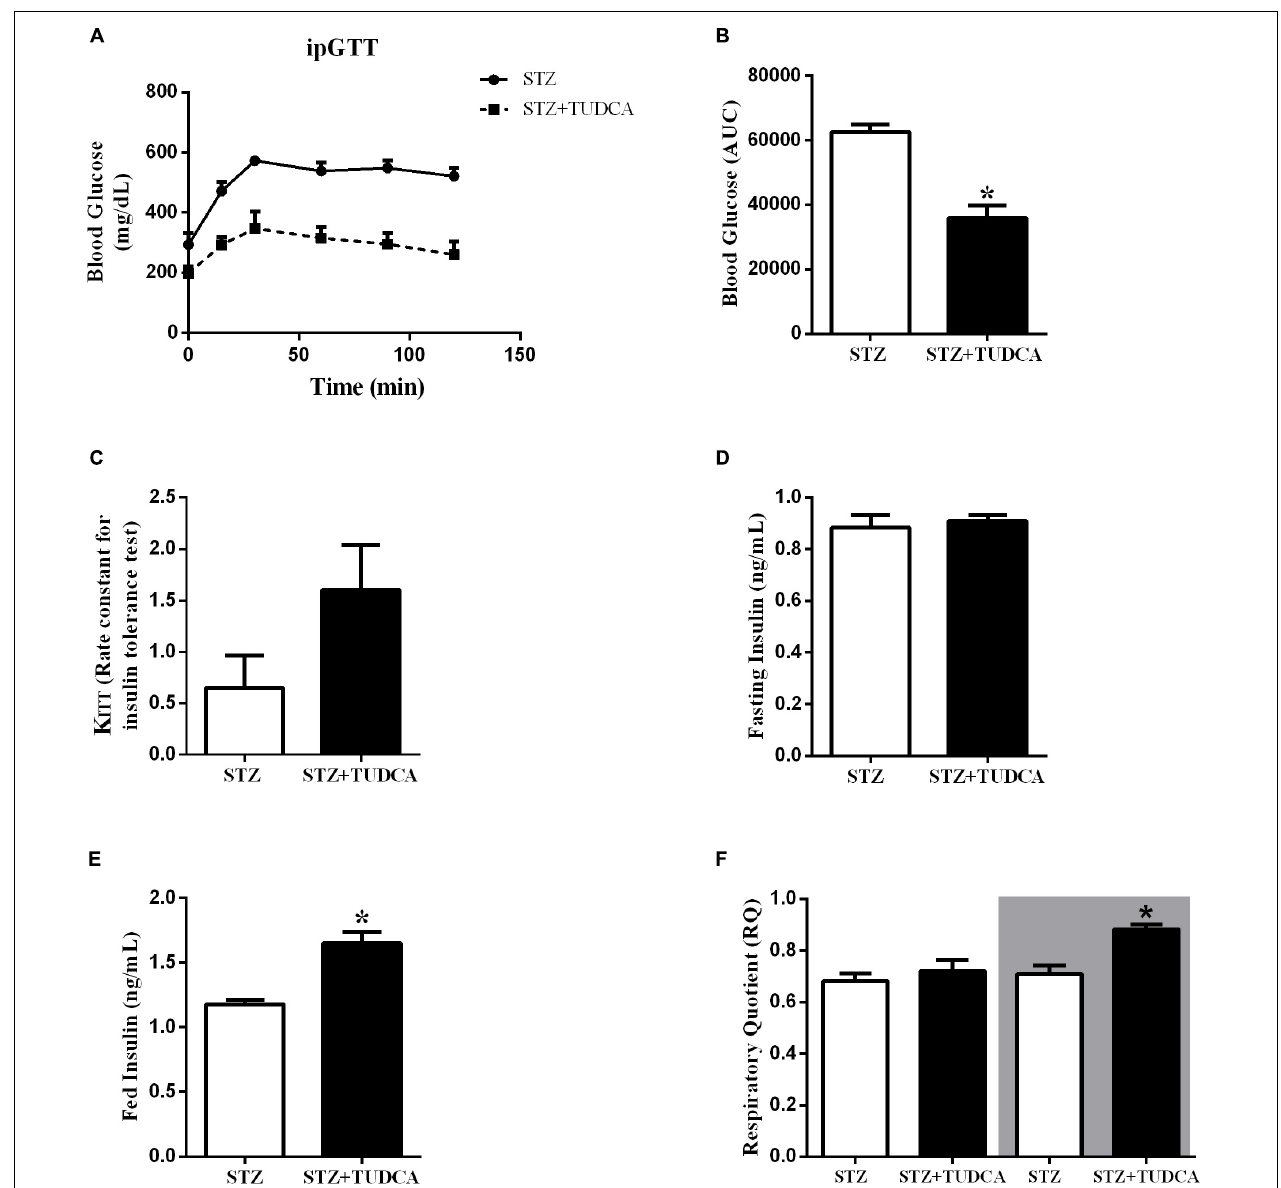
FIGURE 3 | TUDCA treatment improves glucose tolerance, increases insulinemia in a fed state and improves metabolic flexibility in early-stage T1D mice. Blood glucose of STZ (white bar, n = 8) and STZ+TUDCA (black bar, n = 8) during ipGTT (A) . Area under the curve (AUC) of total blood glucose concentration of STZ (white bar, n = 8) and STZ+TUDCA (black bar, n = 8) during ipGTT (B) . Glucose disappearance rate during ipITT (KITT) of STZ (white bar, n = 4) and STZ+TUDCA (black bar, n = 6) (C) . Plasma insulin of STZ (white bar, n = 8) and STZ+TUDCA (black bar, n = 10) in fasting (D) and fed (E) states. Respiratory coefficient (RQ) (F) was determined by indirect calorimetry, during a 12-hour light/dark cycle. RQ of STZ (white bar, n = 4) and STZ+TUDCA (black bar, n = 4) during the light period. In addition, RQ of STZ (white bar with gray background, n = 4) and STZ+TUDCA (black bar with gray background, n = 4) during the dark period. Data are the mean ± SEM. ∗ P ≤ 0.05 (Student’s t -test or Mann-Whitney